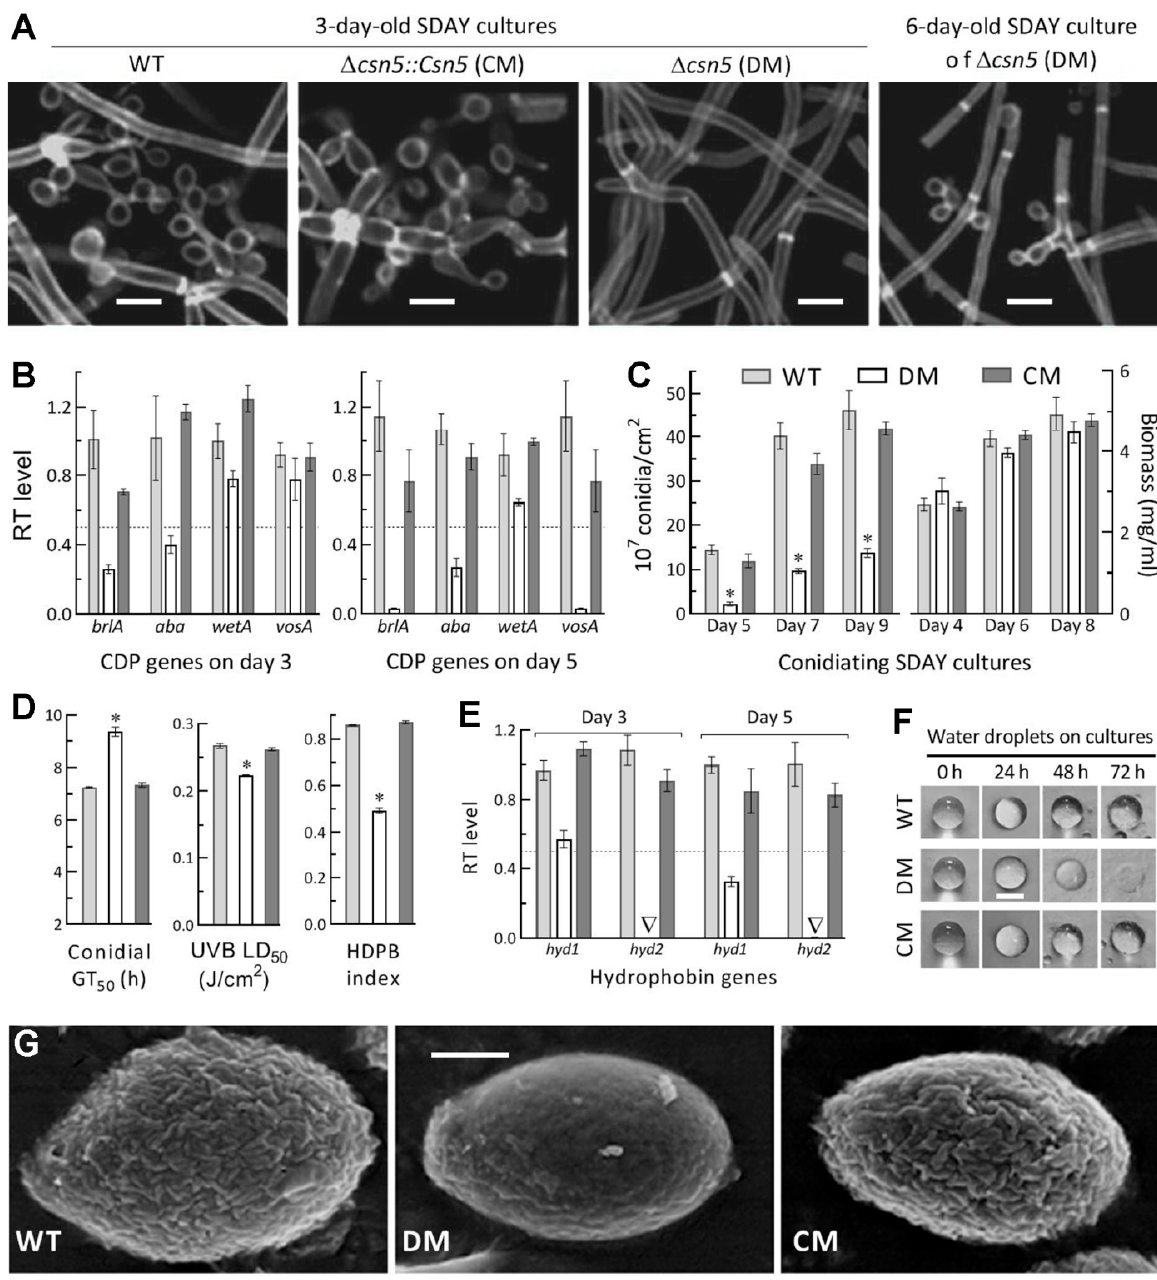
Figure 4. Essential role of Csn5 in the mediation of aerial conidiation and conidial quality. ( A ) Microscopic images of the conidiation status of samples taken from 3- and 6-day-old SDAY cultures and stained with the cell wall-specific dye, calcofluor white. ( B ) Relative transcript (RT) levels of three CDP genes and downstream vosA in the 3- and 5-day-old SDAY cultures of csn5 mutants with respect to the WT standard. ( C ) Conidial yields and biomass levels quantified from the SDAY cultures during a 9-day incubation under the optimal regime of 25°C and L:D 12:12. ( D ) The indices of conidial quality presented by GT 50 for 50% of conidial germination at 25°C, the hydrophobicity (HDPB) index assessed in an aqueous–organic system, and LD 50 for resistance to UVB irradiation. ( E ) RT levels of hyd1 and hyd2 in the 3- and 5-day-old SDAY cultures of csn5 mutants with respect to the WT standard. ( F ) Dispersal of dew-like water droplets on the surfaces of 4-day-old SDAY cultures. ( G ) SEM images (scale bar: 0.5 μ m) for microstructures of the outermost hydrophobin rodlet bundles on conidial surfaces. All SDAY cultures were initiated by spreading 100 μ L of a 10 7 conidia/mL suspension per plate. The dashed line ( B , E ) indicates a significant level of one-fold (50%) downregulation. * p < 0.001 in Tukey’s HSD tests. Error bars: SDs of the means from three independent replicates.